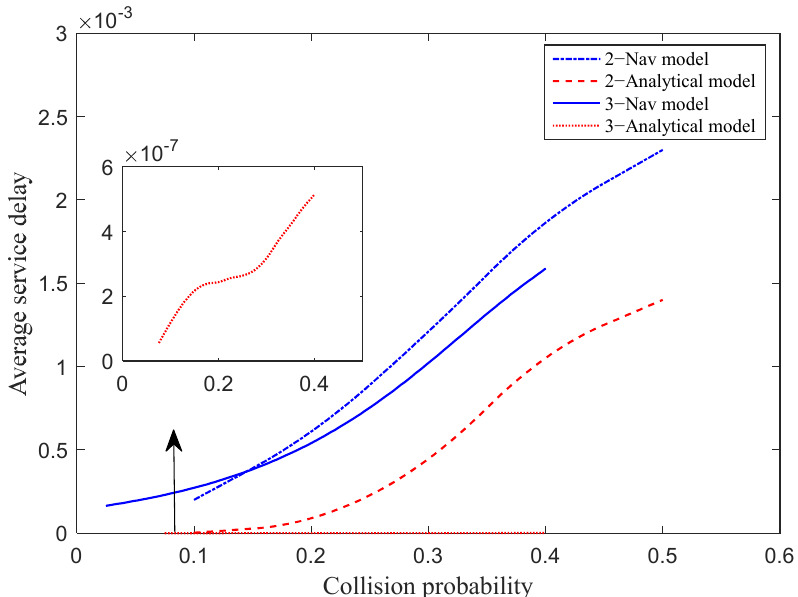
Figure 5. The average service delay with respect to the collision probability in Scenarios 2 and 3.